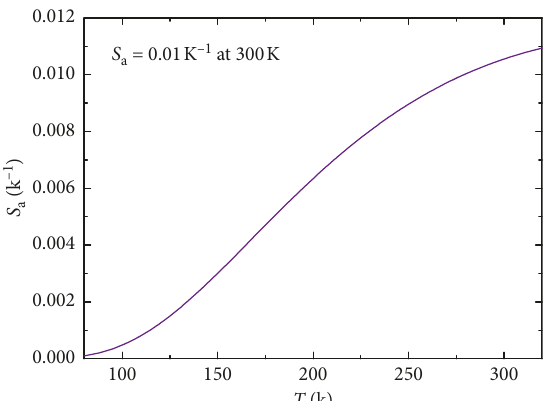
Figure 9: Temperature dependence of the absolute sensitivity S all the